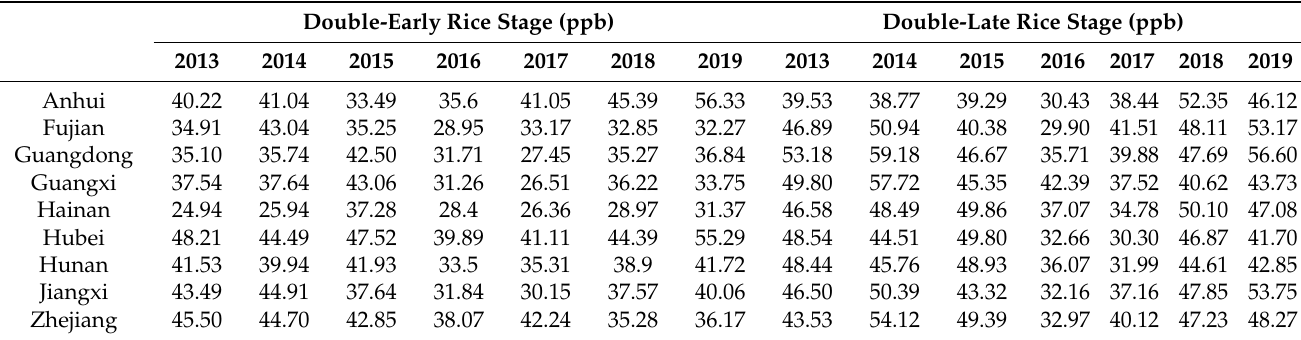
Table 1. Average daytime ozone concentration during the rice growing seasons. Double-Early Rice Stage (ppb) Double-Late Rice Stage